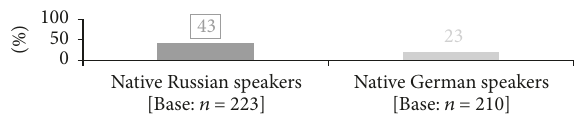
Table 4: Main substitutes (4% and more) for phonogram « 3KS1 »